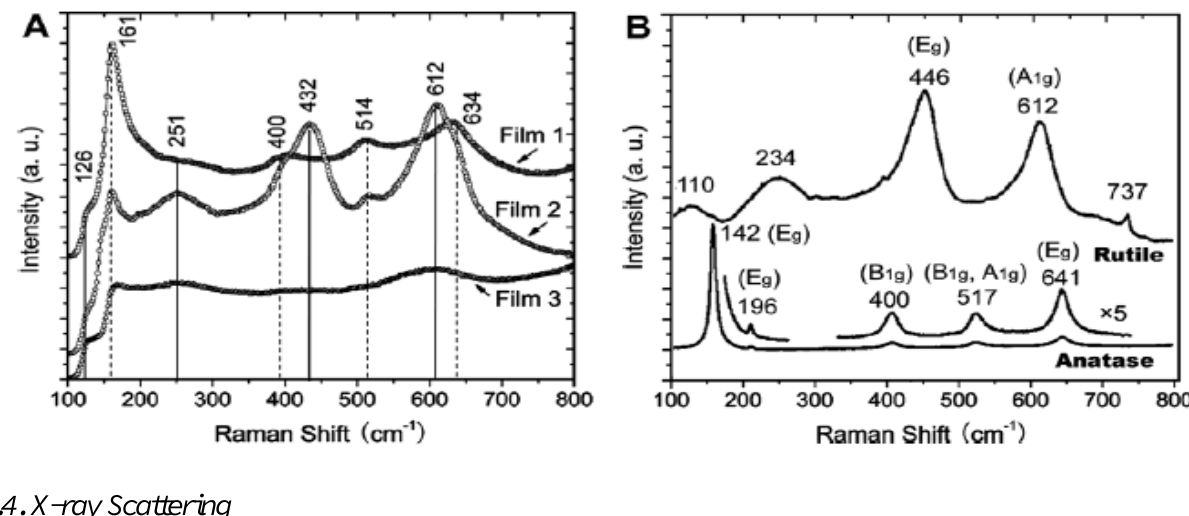
Figure 13. Raman spectra of ( A ) different TiO anatase and rutile. Reprinted with permission from [47]. Copyright 2008